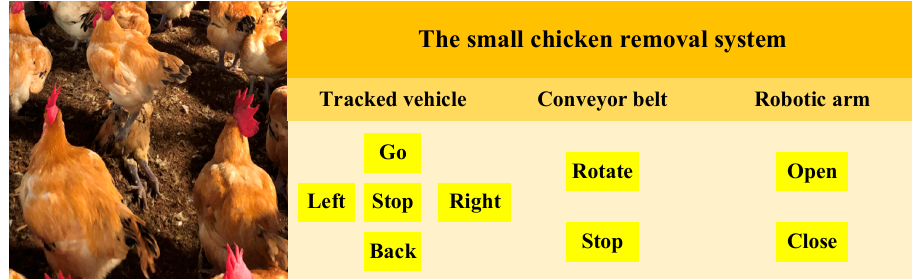
Figure 7. The human–machine interface of the designed